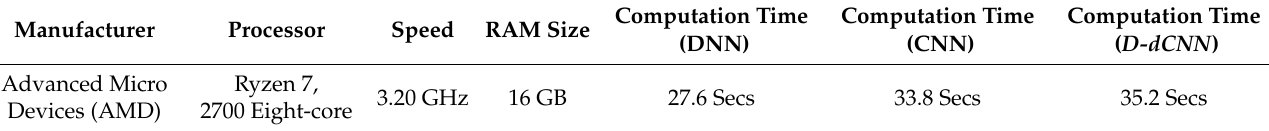
Table 4. Specification of computational hardware